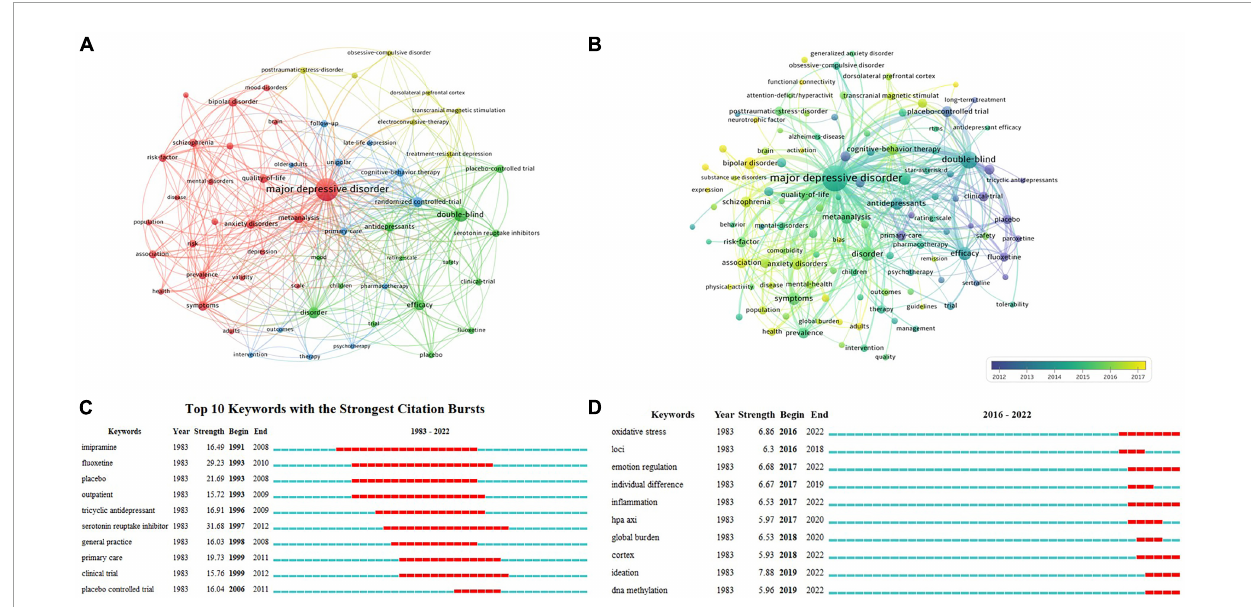
FIGURE4 Analysis of the research hotspots on MDD-related SR/MA [ (A) network visualization map of keywords co-occurrence; (B) overlay visualization map of keywords; (C) top 10 keywords with the strongest citation bursts; (D) keywords with the strongest bursts from 2016 to